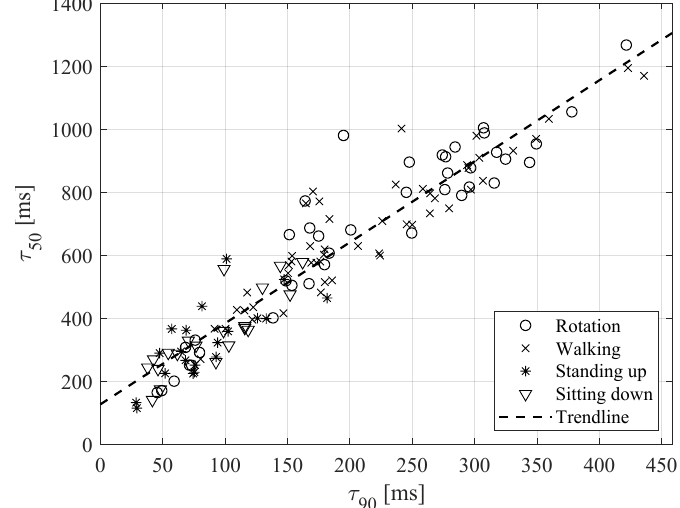
Figure 8. Relation between coherence times resulting from ρ thr = 0.5 and from ρ thr = 0.9 in Equation